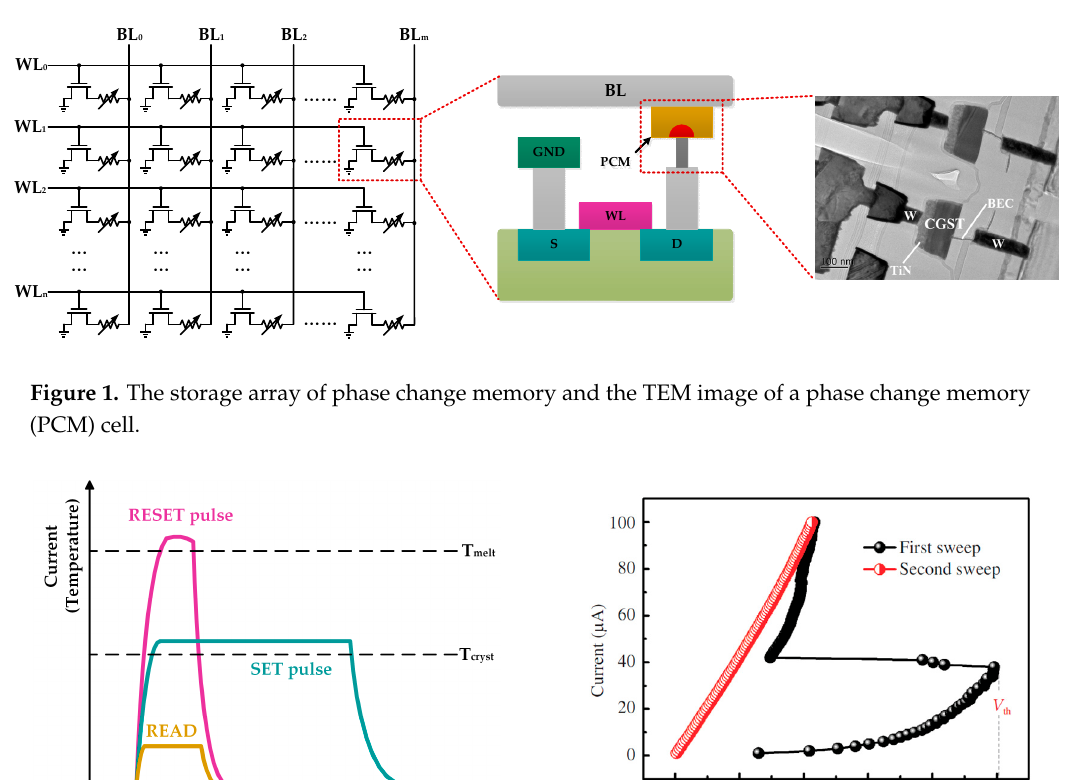
Figure 1. The storage array of phase change memory and the TEM image of a phase change memory (PCM) cell.